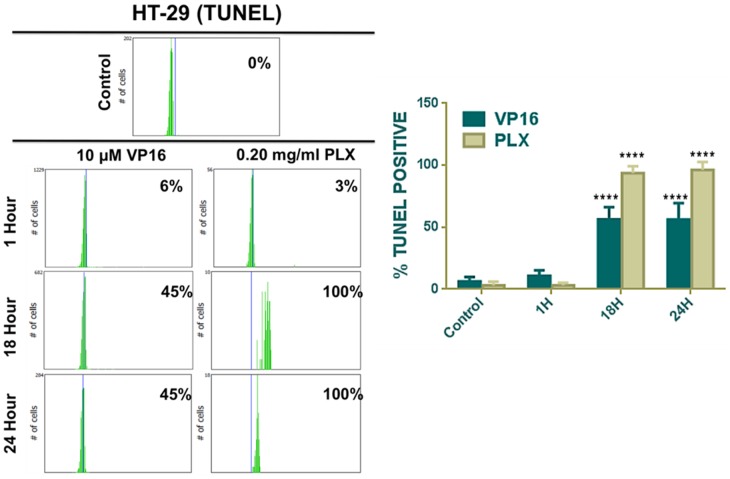
PLX Induces Double-stranded DNA Breaks in Cancer Cells.TUNEL labeling was used to detect DNA fragmentation. Following PLX and VP16 (as a positive control for DNA damage) treatment, cells were labelled with DNA staining solution and quantified by image-based cytometry. Treated cells were compared to the control untreated cell sample. (****P<0.0001).